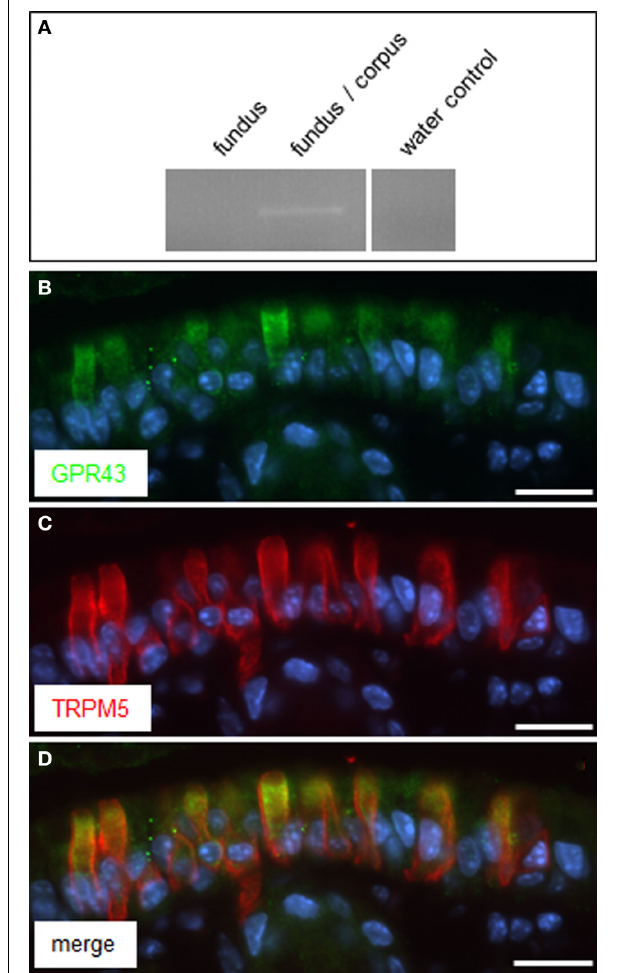
FIGURE 4 | Immunoreactivity for TRPM5 in GPR41 expressing cells. (A) Several elongate cells were weakly stained by the GPR41-antibody (green) . The weaker staining intensity compared to Figures 1 and 2 , respectively, is due to application of different GPR41 antibodies required for technical reasons. Stronger labeling, however was evident at the apical cell pole ( arrowhead ). (B) Immunohistochemical stainings with the TRPM5-antibody (red) resulted in a staining pattern similar for GPR41 in (A) revealing several elongate cells. (C) Overlay of (A) and (B) revealed an overlap of both immunostainings. Sections were counterstained with DAPI ( blue ). Scale bars : (A–C) = 20 μ m.